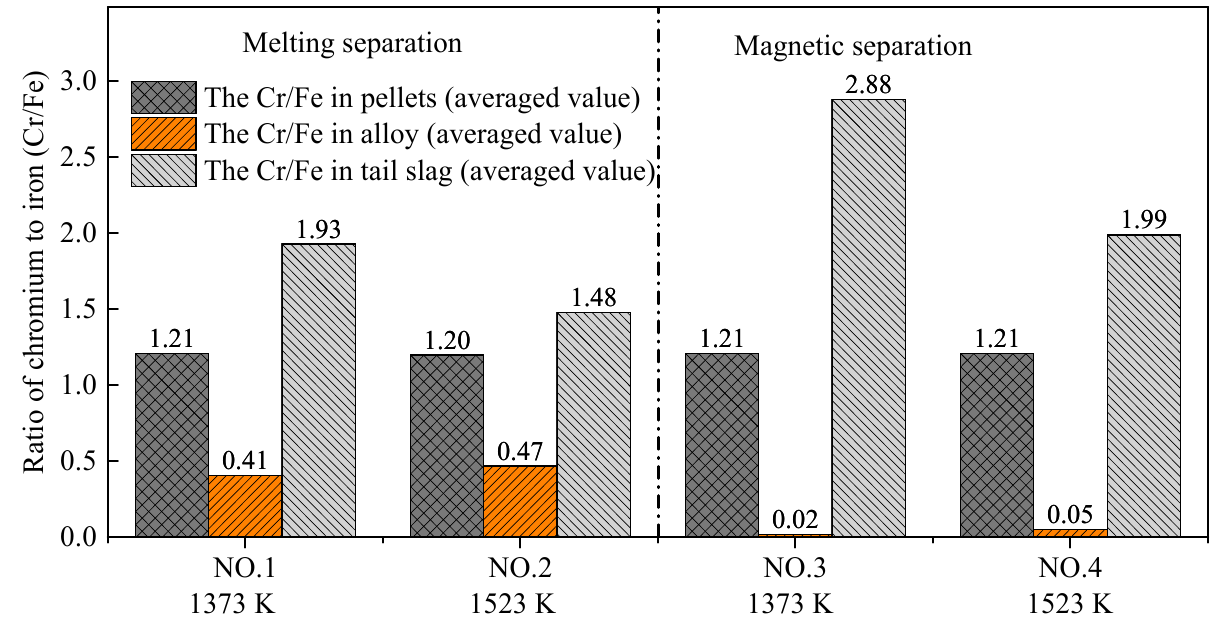
Figure 10. Chromium–iron ratio (Cr/Fe) in pellets, alloy, and tail slag.